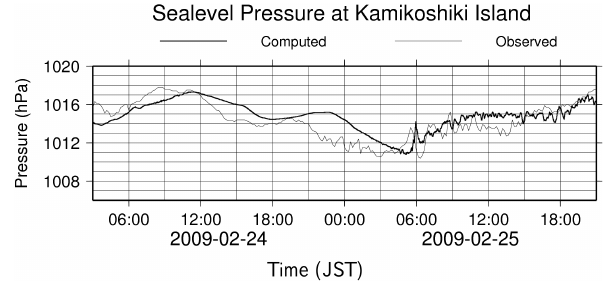
Fig. 15. Time series of the computed sea-level pressure.